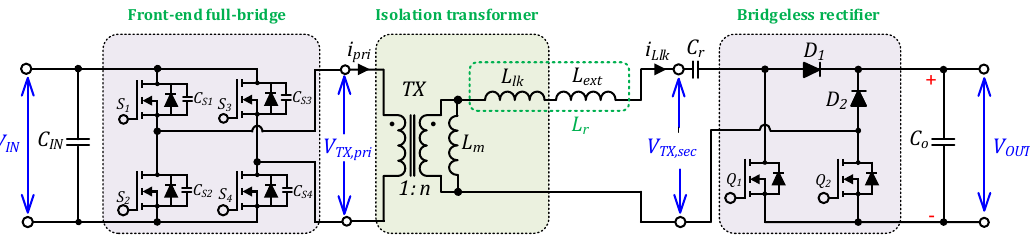
Figure 1. SRC converter based on the bridgeless rectifier in the output-side [11].